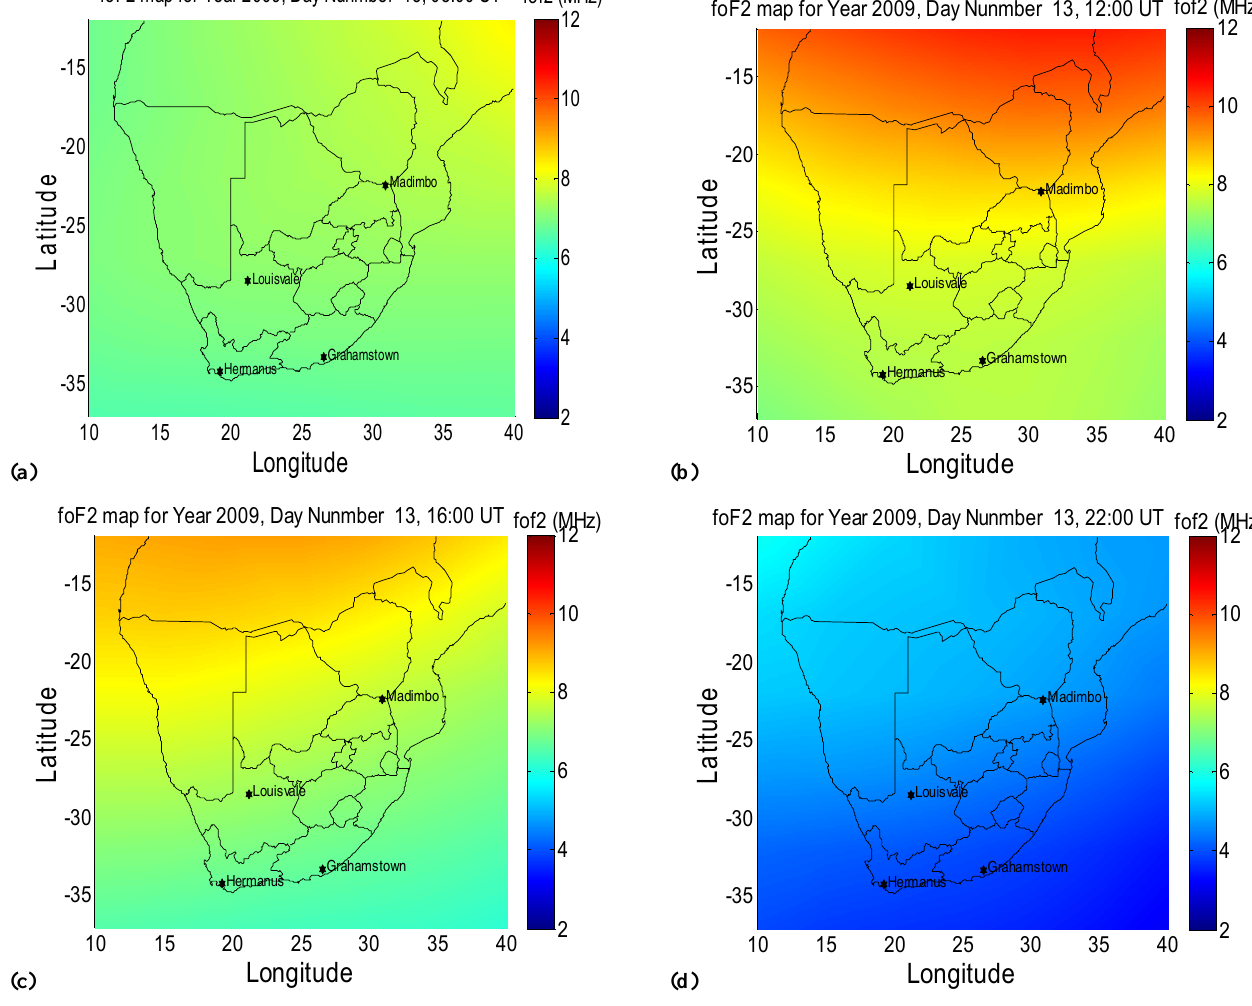
Fig. 3. Variations in fo F2 over South Africa for (a) a morning, (b) an afternoon, (c) an evening and (d) a midnight hour of a summer day in